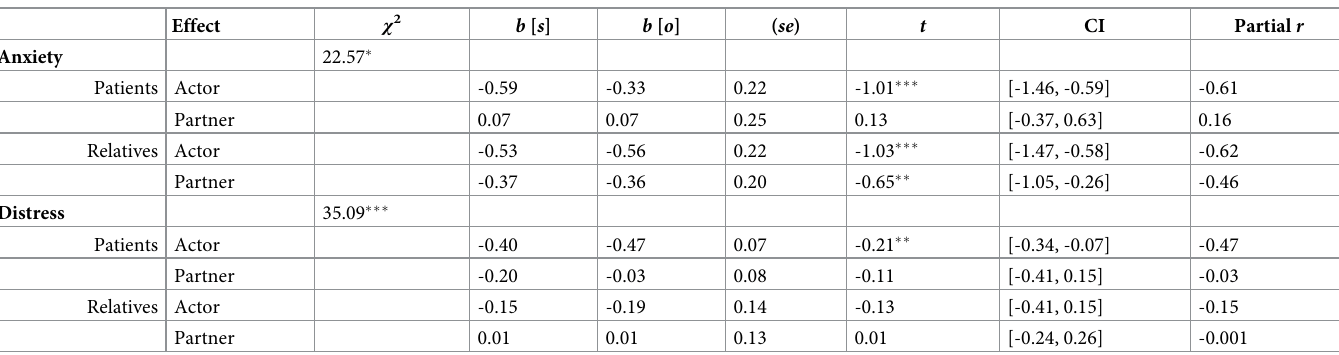
Table 2. Results of the actor-partner interdependence model.